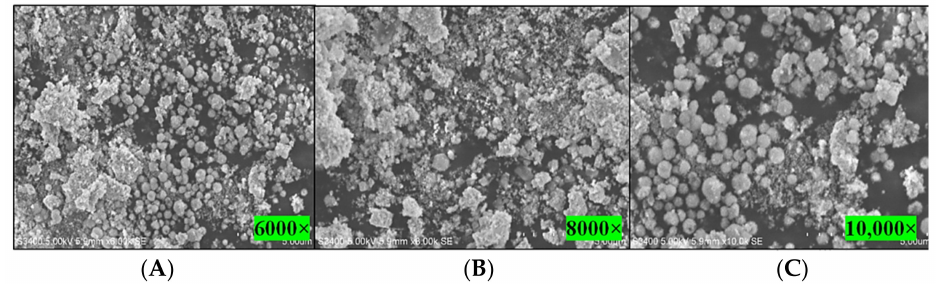
Figure 4. Scanning electron microscopy micrographs of synthesized silver nanoparticles at different magnifications: ( A ) 6000 × , ( B ) 8000 × , and ( C ) 10,000 ×